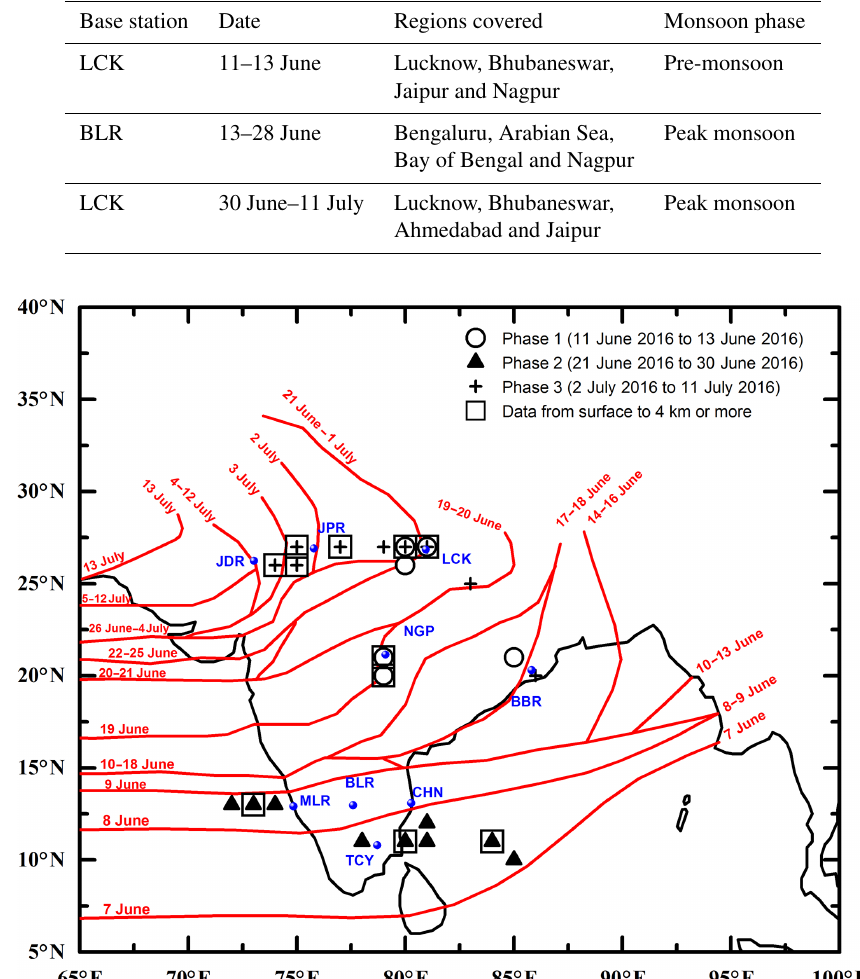
Table 1. The period of measurement from two base stations and details of regions covered during different phases of the monsoon.